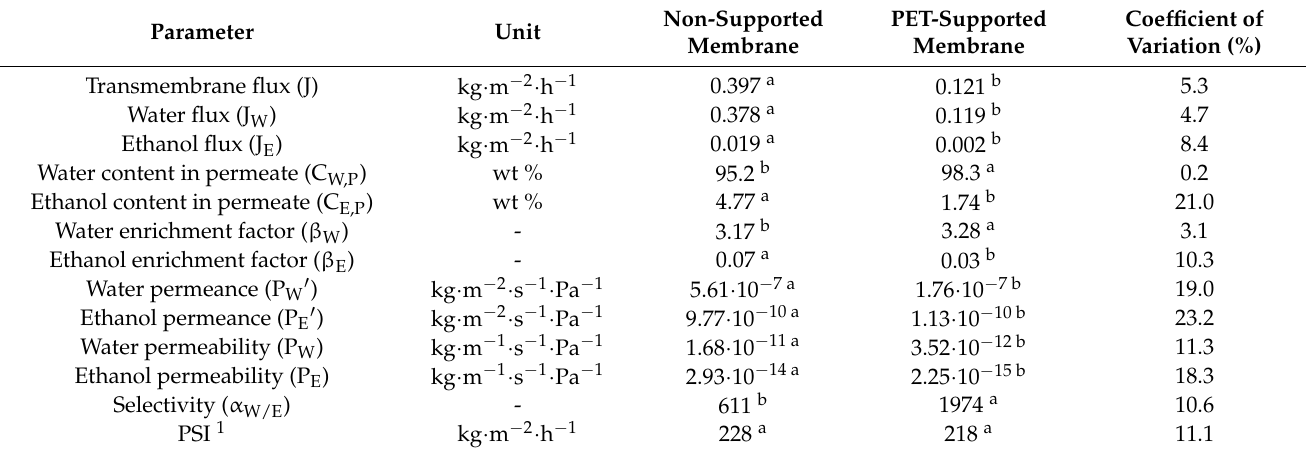
Table 5. Pervaporation parameters for the PET-supported and the non-supported membranes in